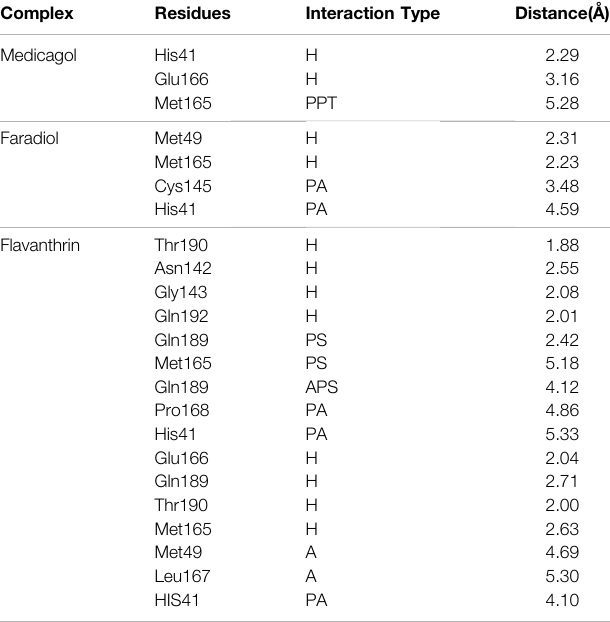
TABLE 4 | The non-bonded interactions of the docked complexes after a 100 ns simulation time; here, H, PPT, A, PA, PS, and APS refer to hydrogen, pi-pi-T- shaped, alkyl, pi-alkyl, pi-sigma, amide pi-stacked bonds,